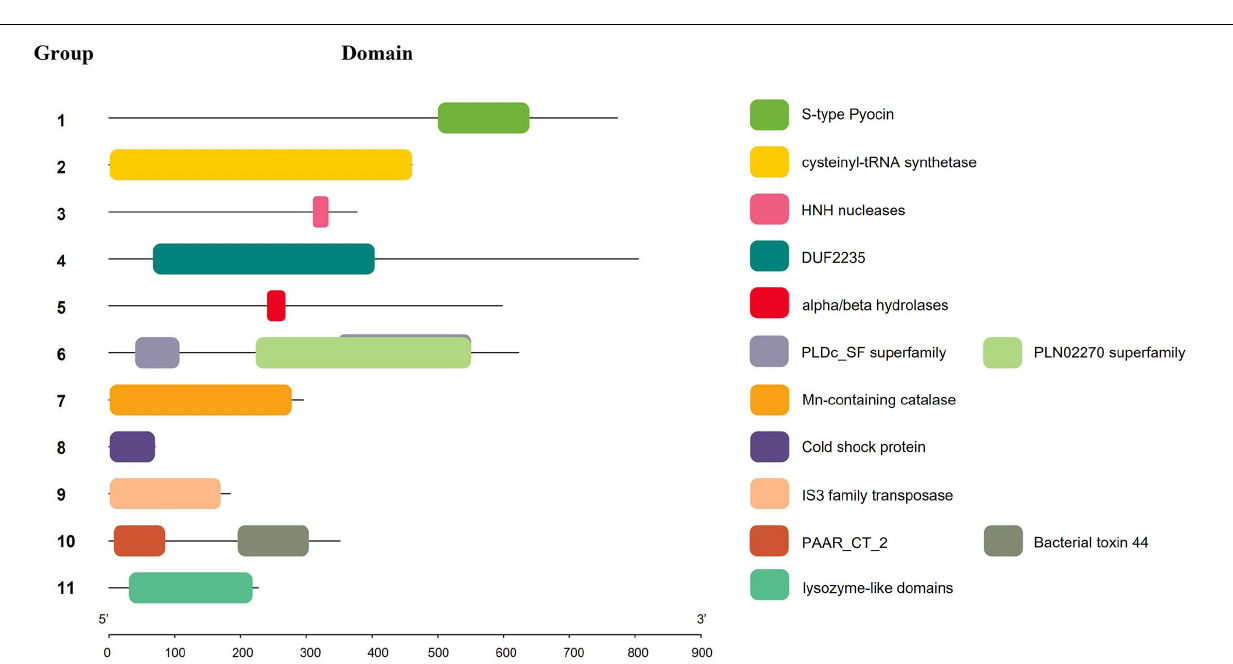
amino acid region with unknown function (DUF2345). However, toxin 44 do not have T6SS_Vgr